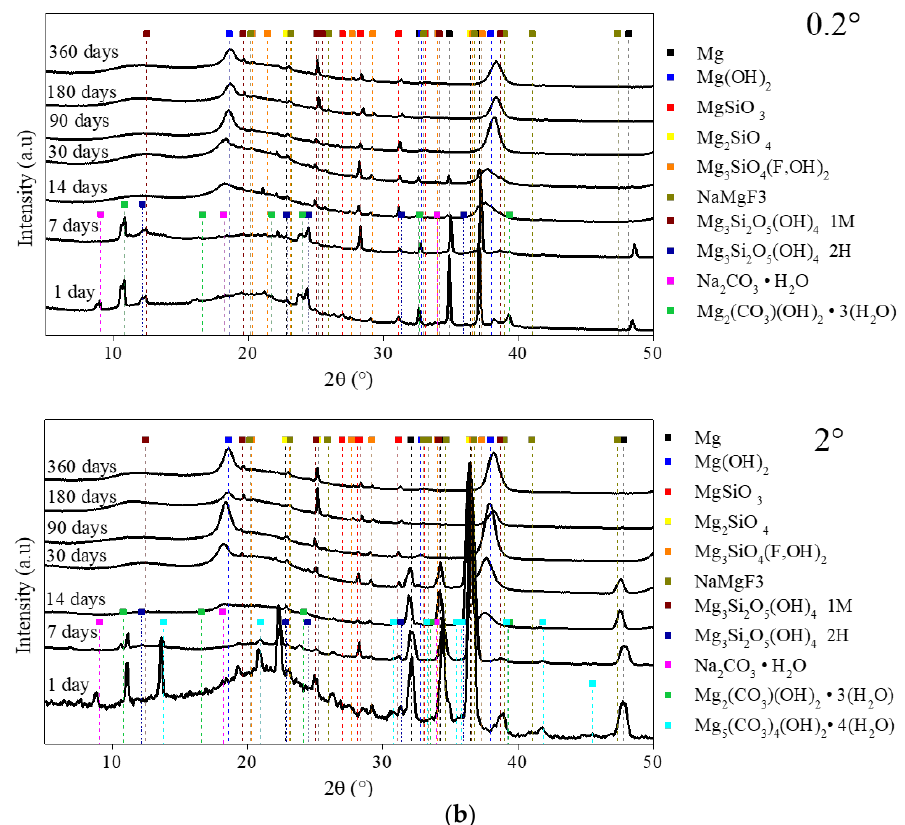
Figure 7. GI-XRD patterns as a function of the corrosion duration of MgZr in ( a ) PS and ( b ) NaF-PS recorded at θ i = 0.2° and 2°.